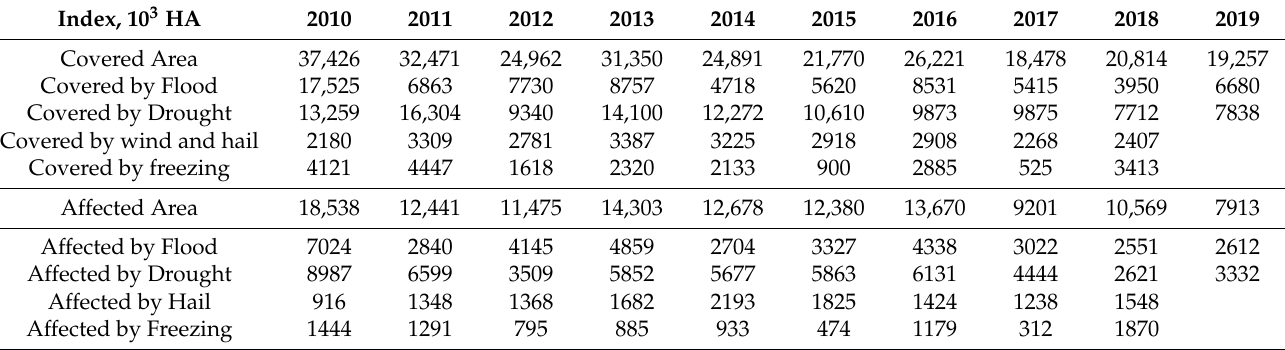
Table 3. Agricultural natural disasters in China during